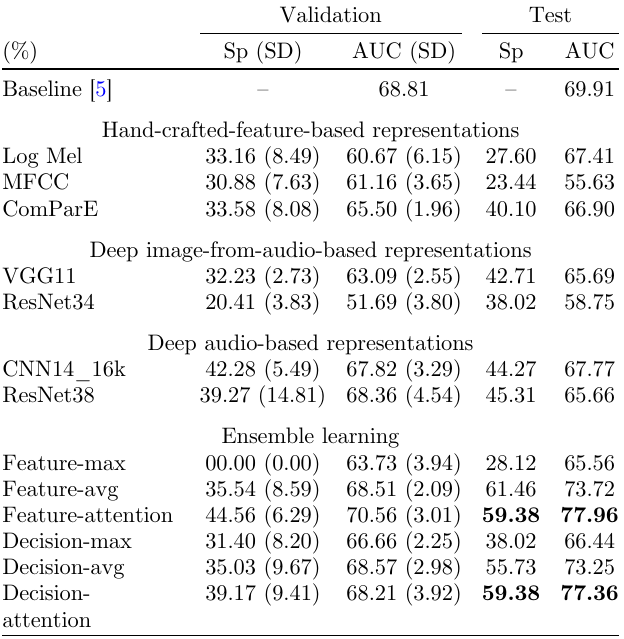
Table 1. Performances of the proposed approaches on the DiCOVA Track-1 database. The performances on the validation sets are averaged over the fi ve folds. SD = standard deviation.